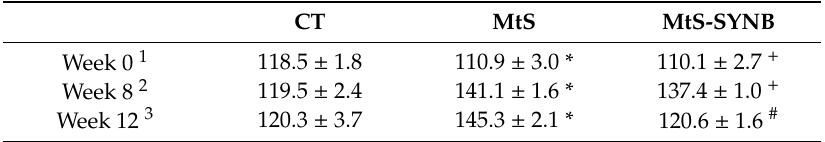
Table 2. Systolic blood